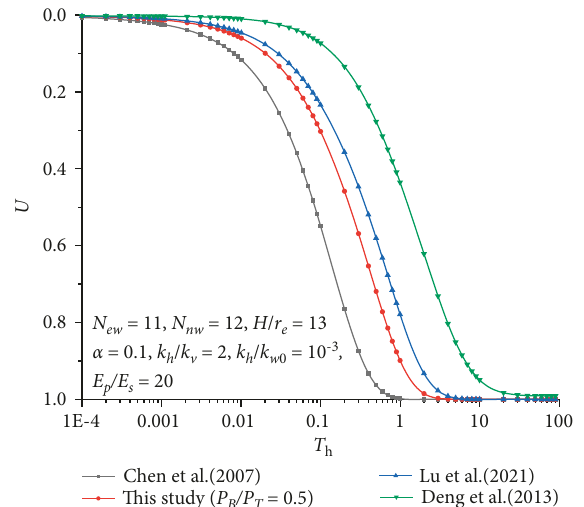
Figure 11: Influence of k H / r